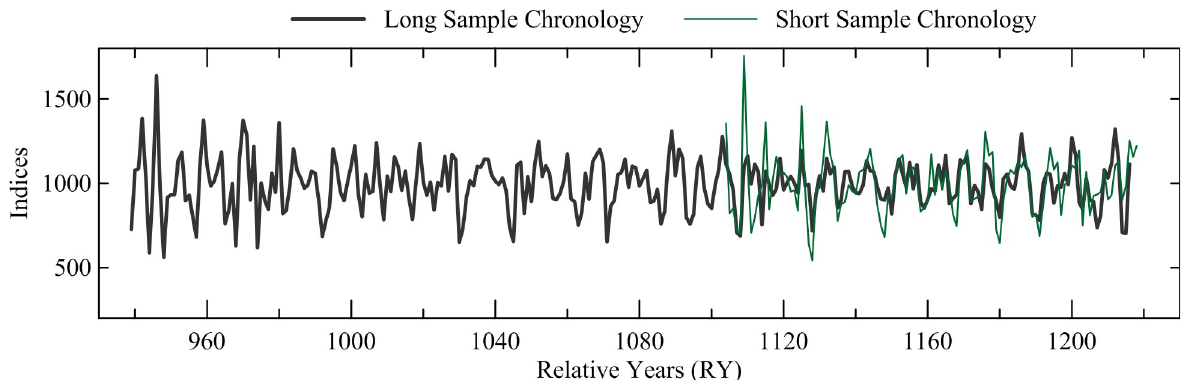
Fig 11. Comparison of the tree-ring widths of the Noceto oak chronology composed of the 9 long sequences with the Noceto oak chronology comprising the 5 short sequences. Supporting statistics are t = 7.42, r = 0.58, tr = 0.67, all with p < 0.01, with an overlap of 113 years.